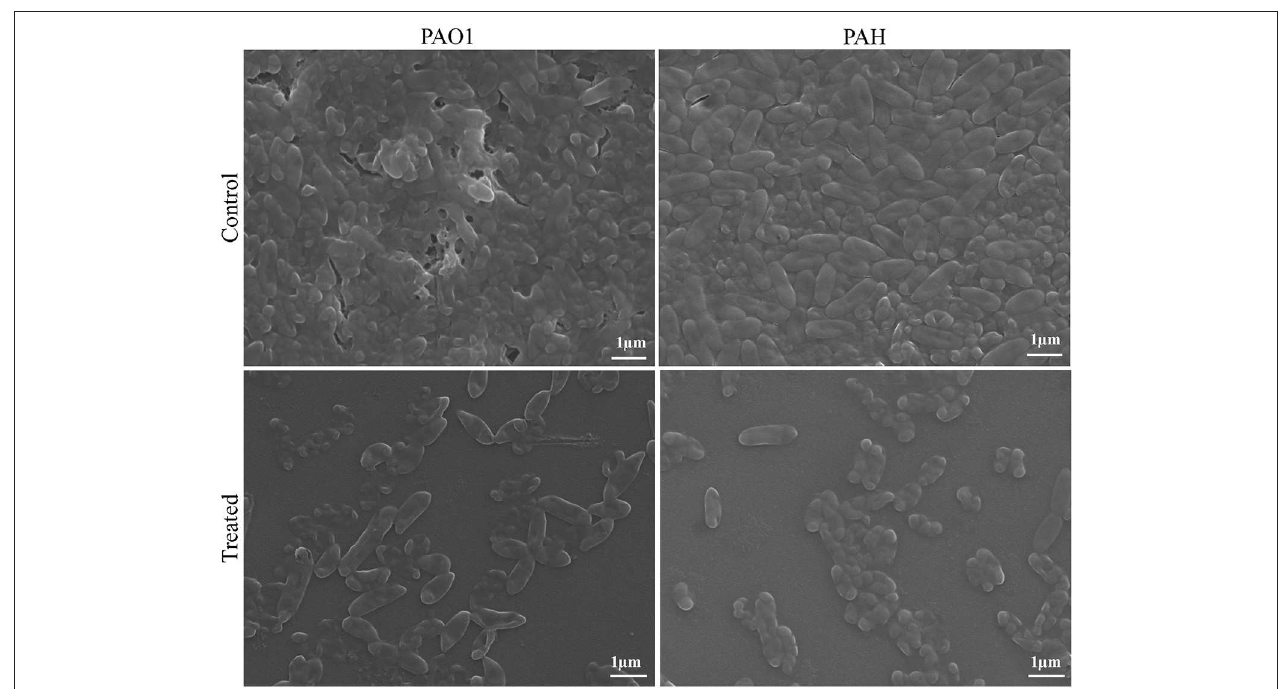
FIGURE 5 | SEM images of biofilms developed by P. aeruginosa . SEM images illustrating the effect of bacterial extract (0.1 mg/ml) on biofilm formation. A well-grown biofilm along with adhering bacterial cells was observed in control (normal biofilm developed by P. aeruginosa ), whereas dispersed bacterial cells were observed in treated